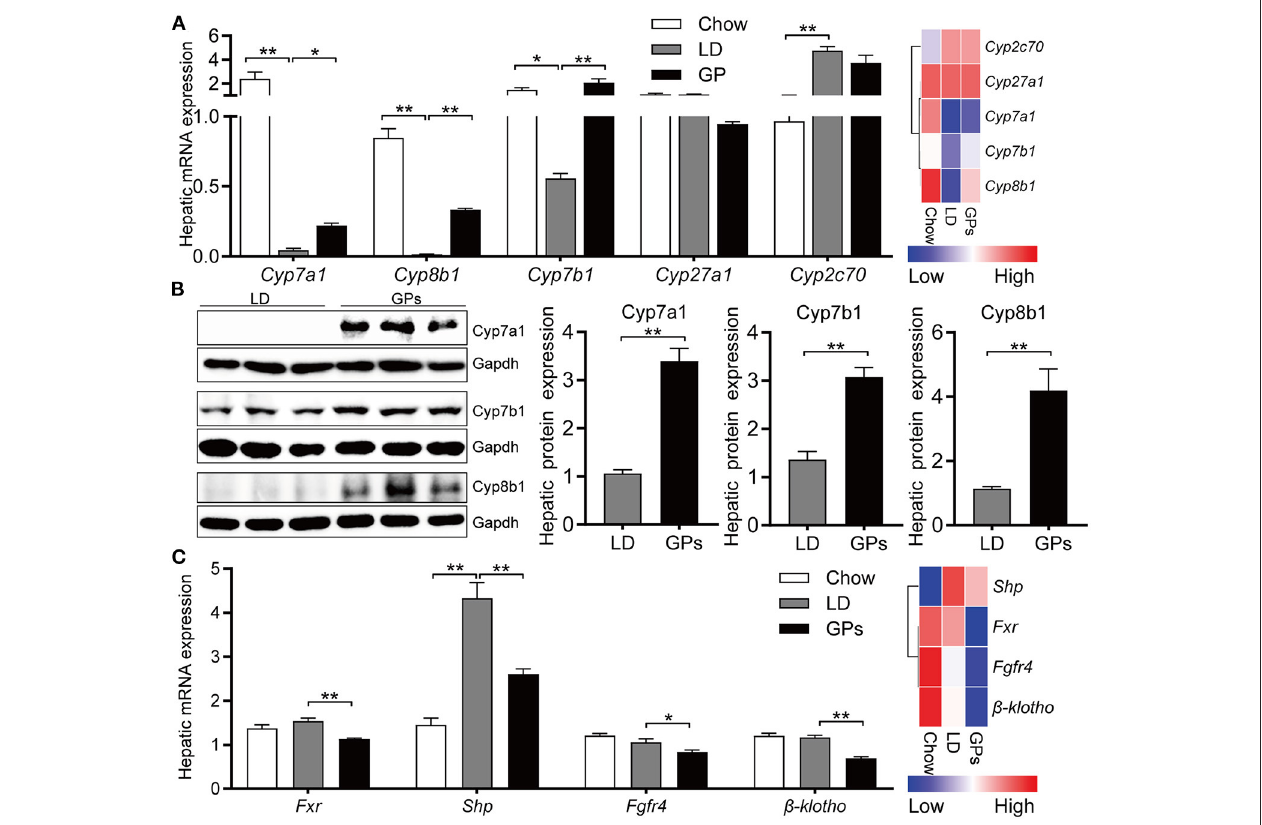
FIGURE 6 | Hepatic expression of genes involved in bile acid synthesis and regulation. (A) Levels of expression of Cyp7a1 , Cyp8b1 , Cyp7b1 , Cyp27a1, and Cyp2c70 mRNAs measured by qRT-PCR (left panel, n = 8) and RNA sequencing (RNA-seq) analyses (right panel, data shown as means). (B) Protein expression and quantification of Cyp7a1, Cyp781, and Cyp7b1 ( n = 6). (C) Levels of expression of Fxr , Shp , Fgfr4 and β -klotho mRNAs measured by qRT-PCR (left panel, n = 8) and RNA-seq analyses (right panel, data shown as means). Data are reported as means ± SEM. * P < 0.05, ** P <